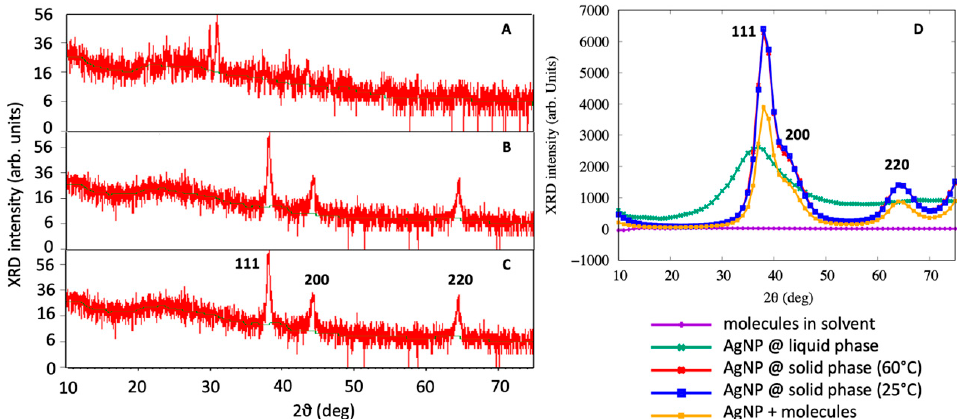
Figure 4. X-Ray diffraction spectrum of ( A ) flower extract of Couroupita guianensis , ( B ) of biosynthesized AgNPs at 25 °C and ( C ) at 60 °C and ( D ) of MD simulations.